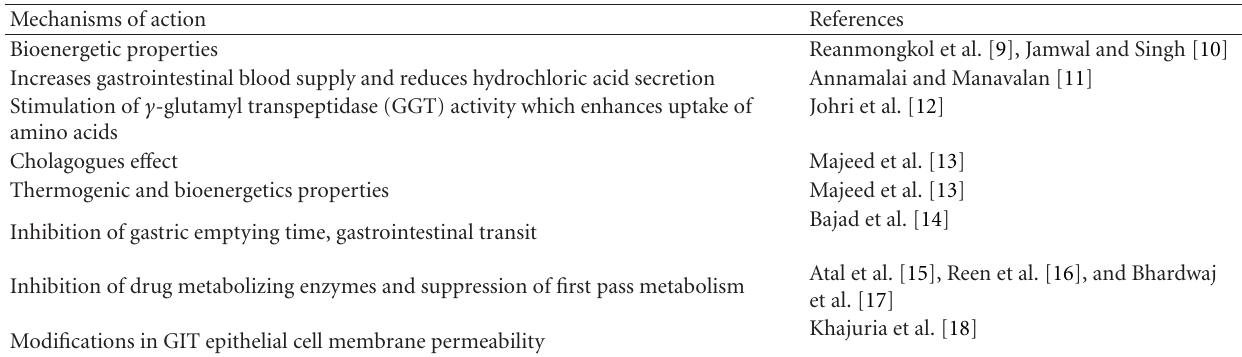
Table 1: Mechanisms of action of herbal